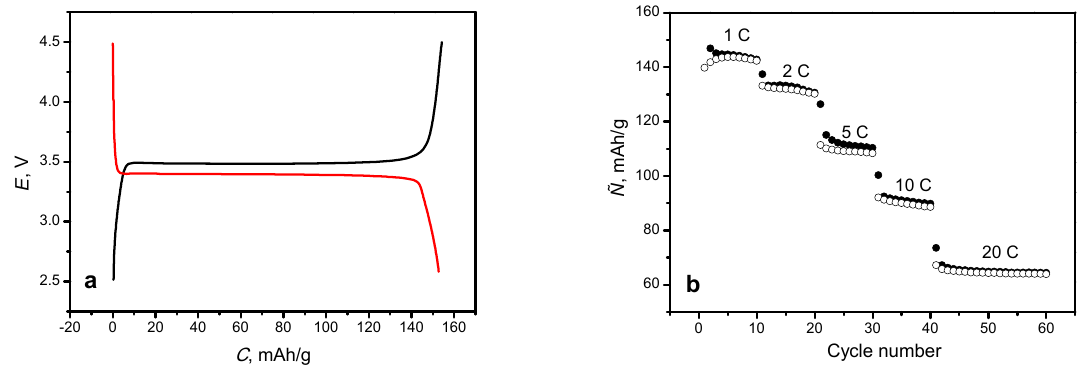
Figure 5. Electrochemical characteristics of synthesized material: ( a ) the second charge/discharge curve at 0.1 C; ( b ) cycling at different C rate.